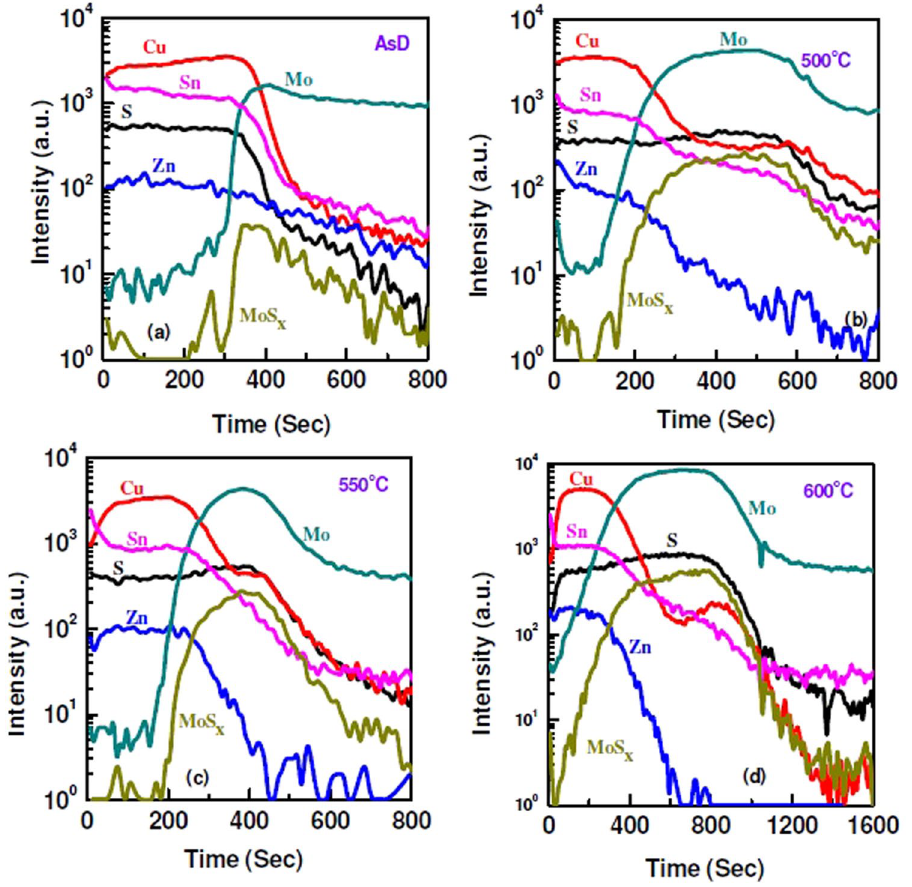
Figure 5. SIMS profile of elemental atoms from CZTS/Mo structure for ( a ) as-deposited CZTS film and after sulphurizationat ( b ) 500 °C, ( c ) 550 °C and ( d ) 600 °C.